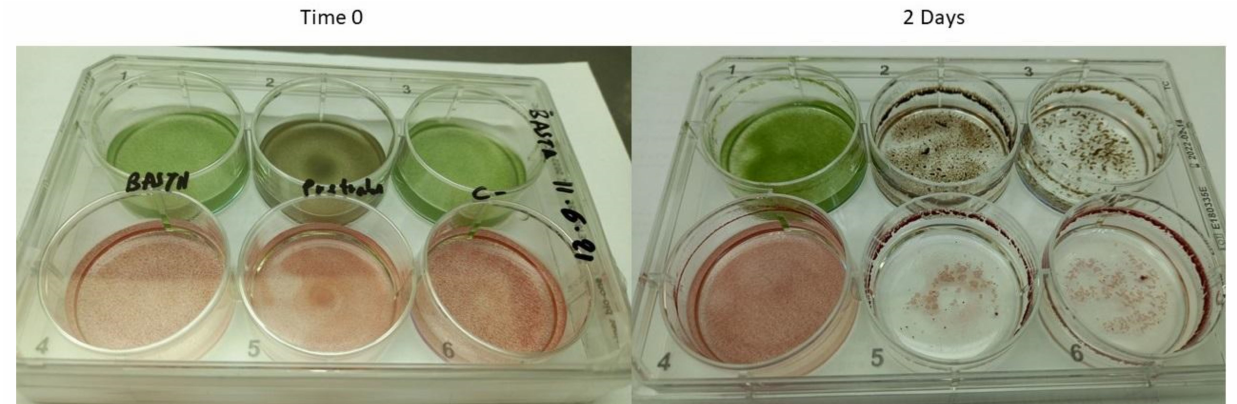
Figure 1. Effect of 2.5 mM of glufosinate on the infection of H. lacustris by P. sedebokerense . Epidemic development in green (upper row) and red nitrogen starved (lower row) H. lacustris culture, two days after inoculation with 5 × 10 5 P. sedebokerense propagules, at a propagules/host ratio of 1:1. We tested the epidemic development in the presence of 2.5 mM glufosinate (left column of each plate), in H. lacustris cells pretreated with 2.5 mM glufosinate (central column of each plate) and in the absence of glufosinate (negative control) (right column of each plate). Left plate, zero-time control; right plate, same plate after two days (lid was removed before